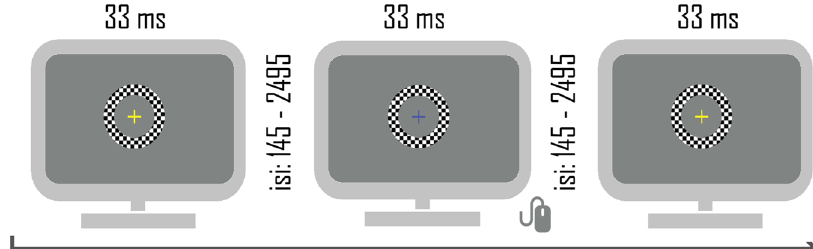
Fig. 1 Visual adaptation task. Checkerboards were presented for 33 ms. In fi ve blocked conditions, the ISI was either 145, 245, 495, 995, or 2495